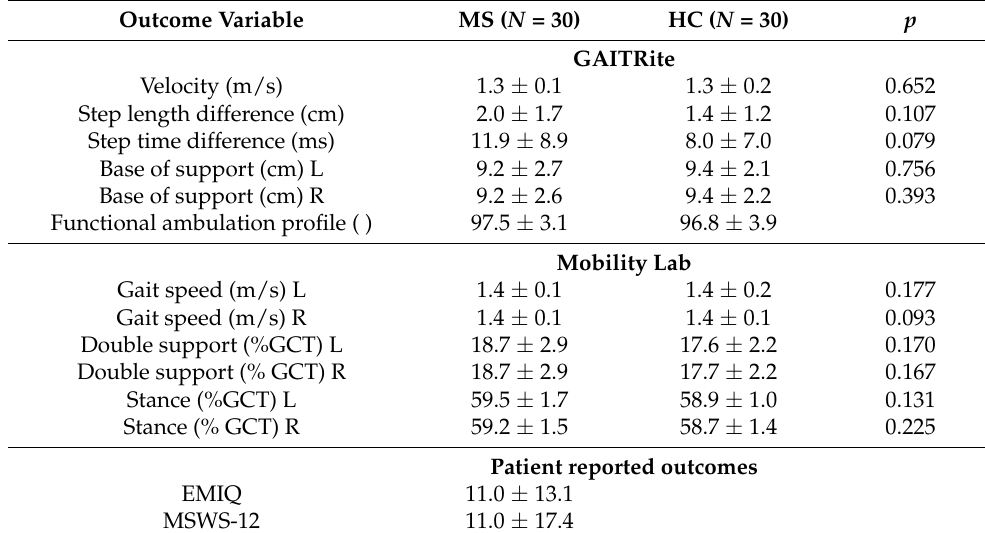
Table 3. Selected gait parameters for people with MS and healthy controls ( N = 60). Key parameters used in clinical routine according our DMWA protocol [33]; MS = multiple sclerosis; HC = healthy